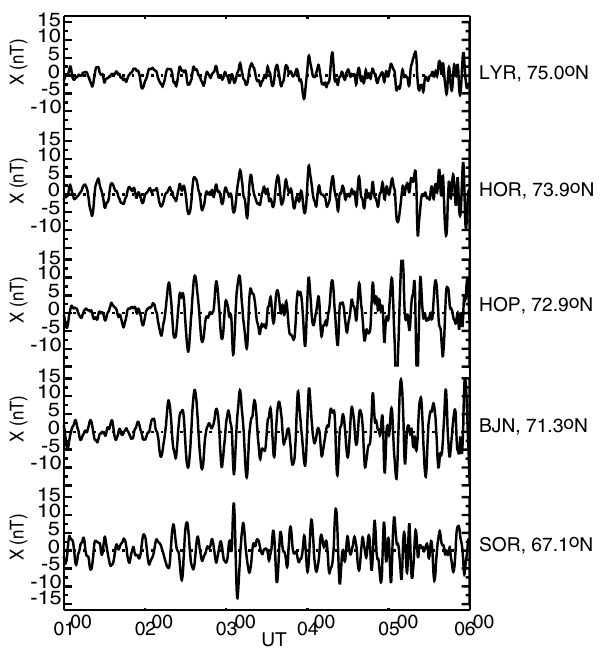
Fig. 7. Data from the EISCAT Svalbard Radar, 20 December 1998, (a) electron density, (b) electron temperature, (c) ion velocity. Data from CUTLASS Finland on a reduced latitude scale from Fig. 3, (d) line-of-sight velocity and (e) spectral width “G.S” denotes intervals of ground